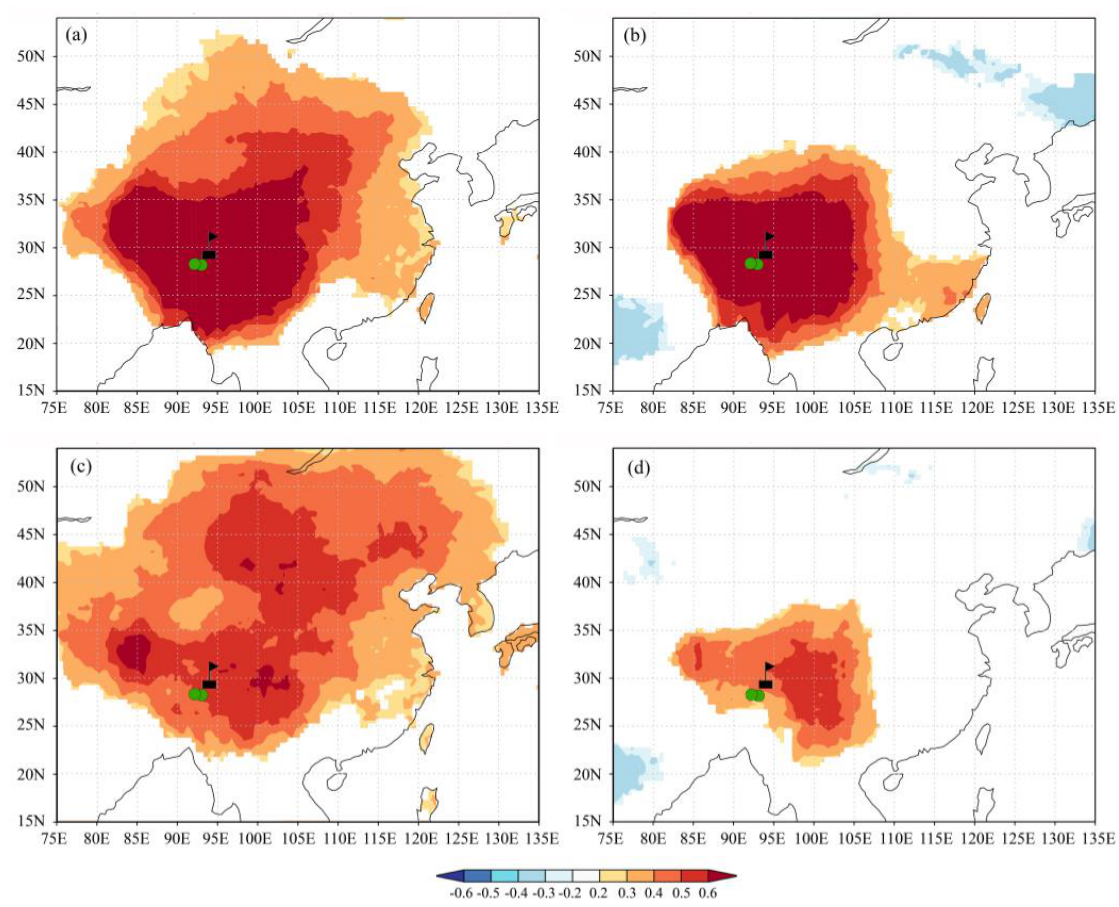
Figure 5. Spatial correlation fields of the observed ( a , b ) and reconstructed ( c , d ) Tmean 7 with the gridded Tmean 7 . Spatial correlation for the original ( a , c ) and first-differenced ( b , d ) data for the period 1979–2020. The green dots show the locations of sampling sites, and the black flag shows the location of the meteorological station.